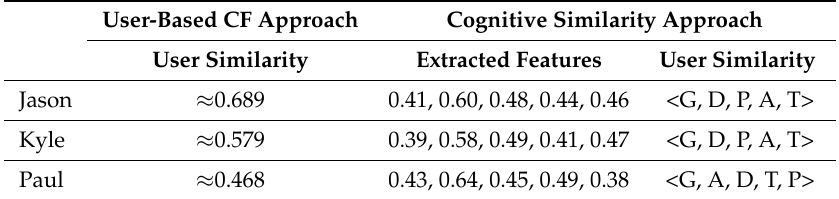
Table 1. Comparison between tradition CF with the user-based approach and our proposed method in considering the relation of users Jason , Kyle and Paul